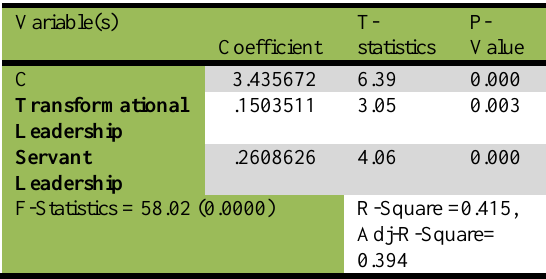
Table 5: Summary of Hypothesis 3 Result